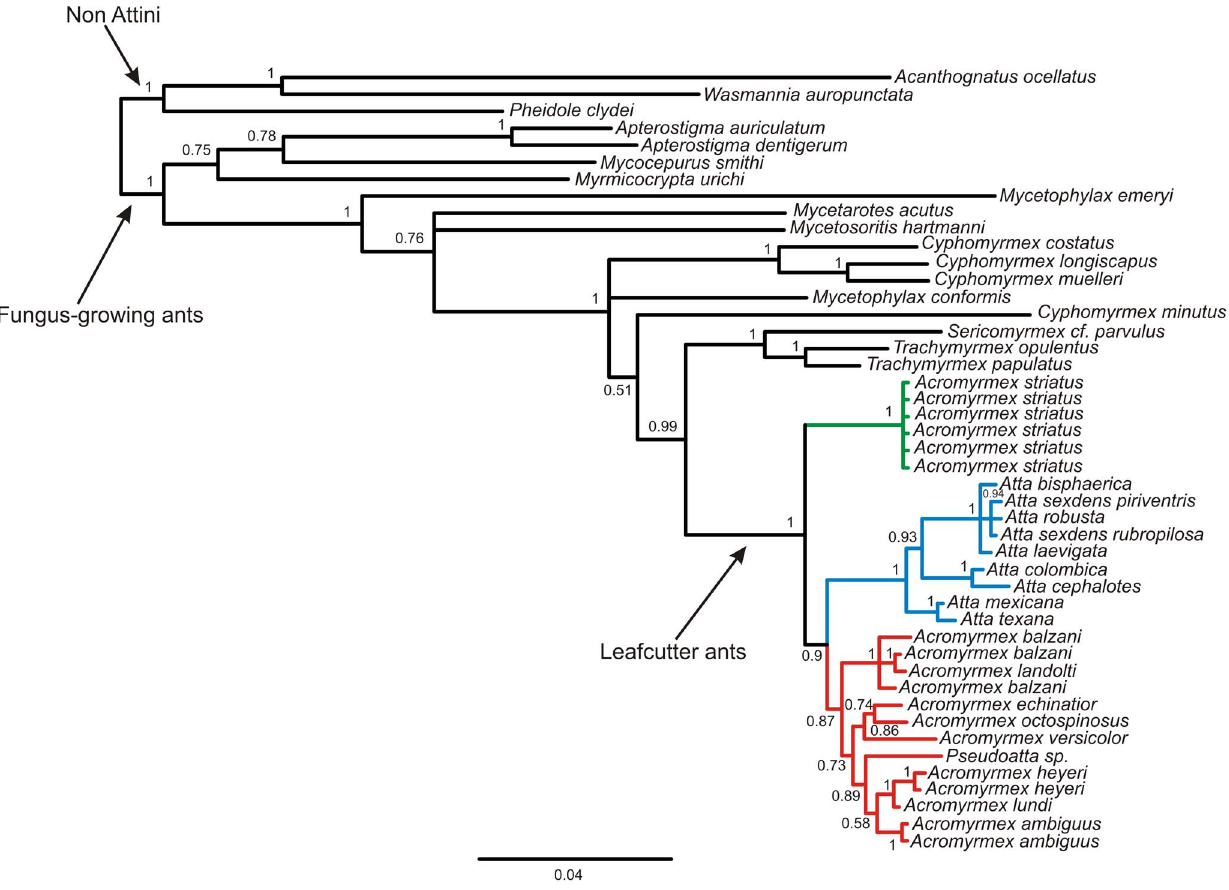
Figure 4. Bayesian inference phylogenetic tree based on the concatenated sequences of four nuclear genes (WG, LW, EF1 a F1 and EF1 a F2). Sequences are identified by organism name. Numbers above the nodes indicate the posterior probabilities from the Bayesian analysis. Clades of leafcutter ants and fungus-growing ants are indicated by arrows. The clustered groups of Acromyrmex species, Atta, and Acromyrmex striatus are represented as red, blue, and green, respectively. The topology was rooted using three species in the Myrmicinae subfamily.